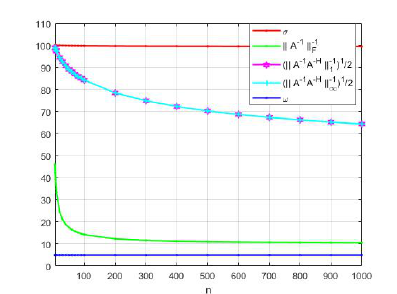
Figure 6: a 1 , a 2 , a 3 , a 4 , a 5 , a 6 , a 7 = 14/5, 1/5, 2/5, 1, 3/5, 4/5, 1/5 [i=7].